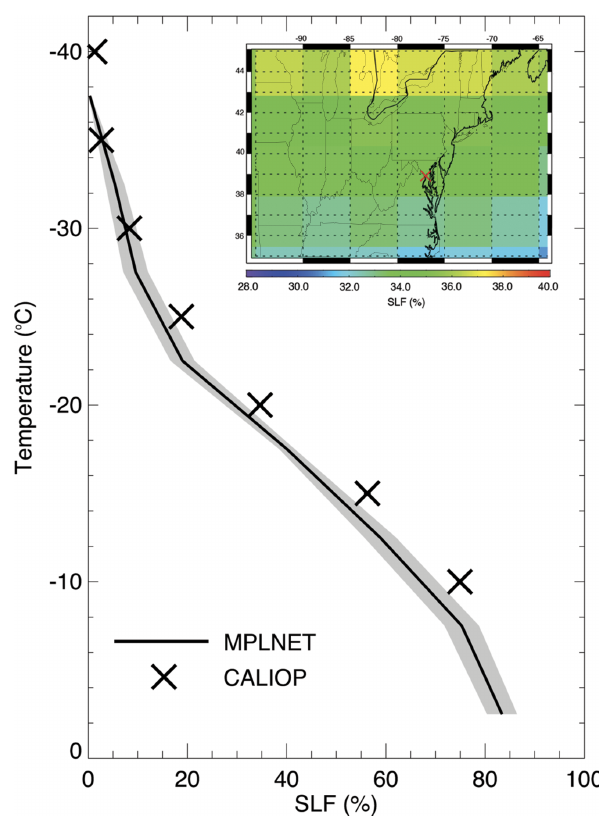
Figure 9. Supercooled liquid fraction (SLF) averaged over GSFC (2015–2019) from MPLNET (solid line) and CALIOP (black × ) observations. The inset shows the horizontal distribution of CALIOP SLFs at the − 20 ◦ C isotherm surrounding GSFC (indi- cated by the red × ). The CALIOP SLF profile is calculated us- ing the 2.5 ◦ latitude × 5 ◦ longitude grid box containing GSFC. The shaded area indicates the standard error for MPLNET observations. CALIOP standard errors are less than 0.7 at all